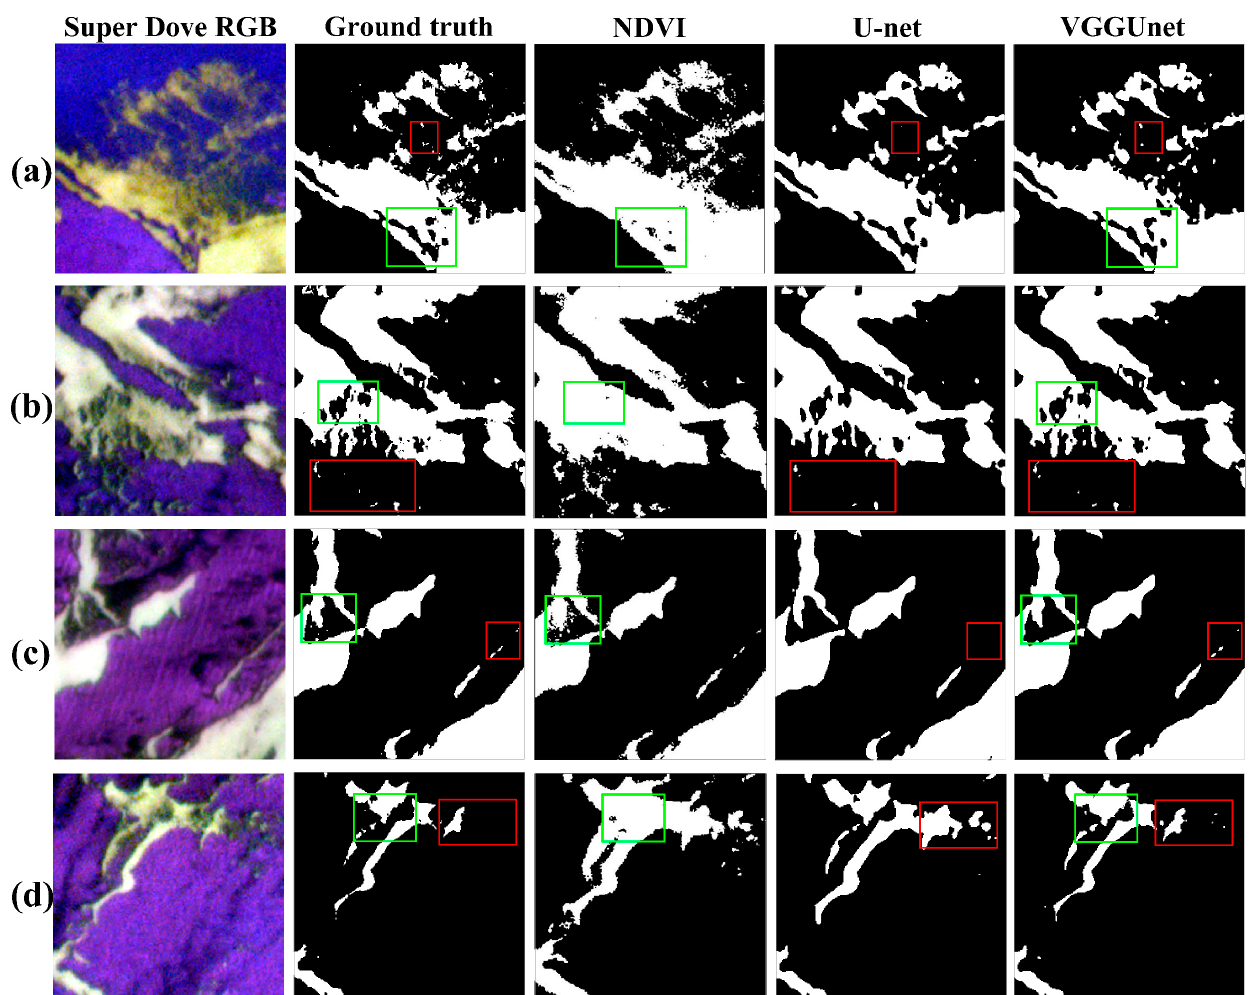
Figure 5. Comparison of U. prolifera extraction results from NDVI, the U-net model, and the VGGUnet model on Super Dove images. ( a – d ) Five test images: the Super Dove RGB image, the ground truth image, the U. prolifera extraction result from NDVI, the U. prolifera extraction result from the U-net model, and the U. prolifera extraction result from the VGGUnet model. The key parts of the comparison between NDVI and the ground truth and the VGGUnet model are shown in red rectangles, while those between the U-net model and the ground truth and the VGGUnet model are shown in green rectangles.